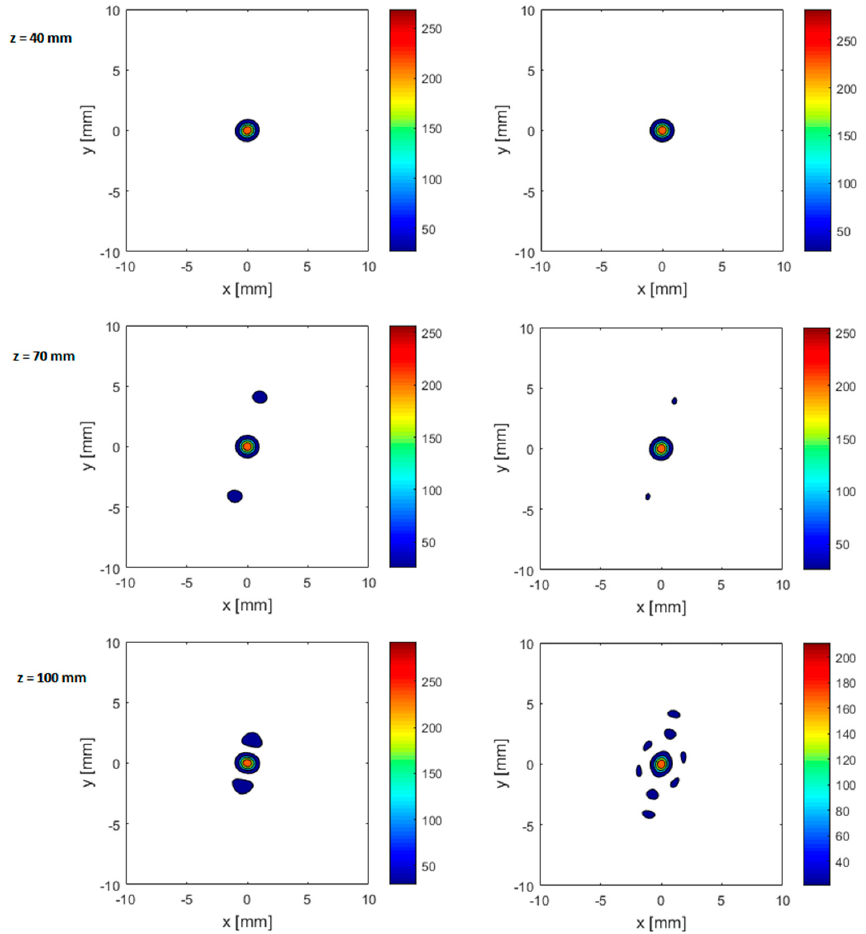
Figure 7. Intensity distribution and focus splitting in the transverse focal plane, for anatomically correct ribs positioned at